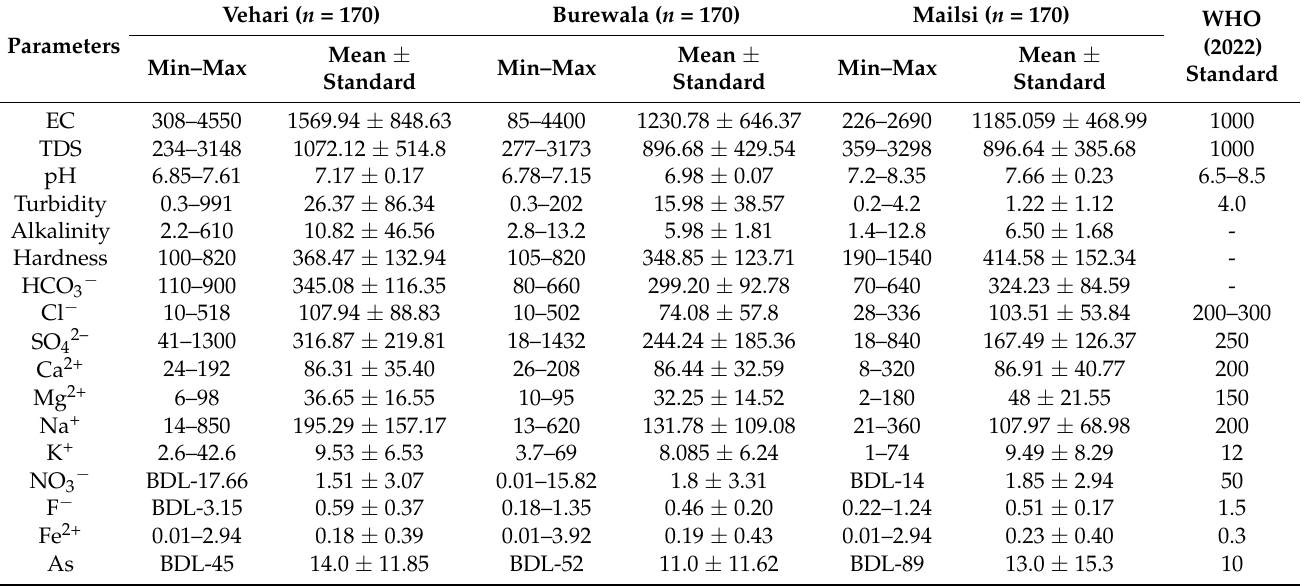
Table 1. Statistical physicochemical parameters of groundwater in three tehsils. All parameters are in (mg/L), except for pH, As ( µ g/L), EC ( µ S/cm), and turbidity (NTU). Below detection limit